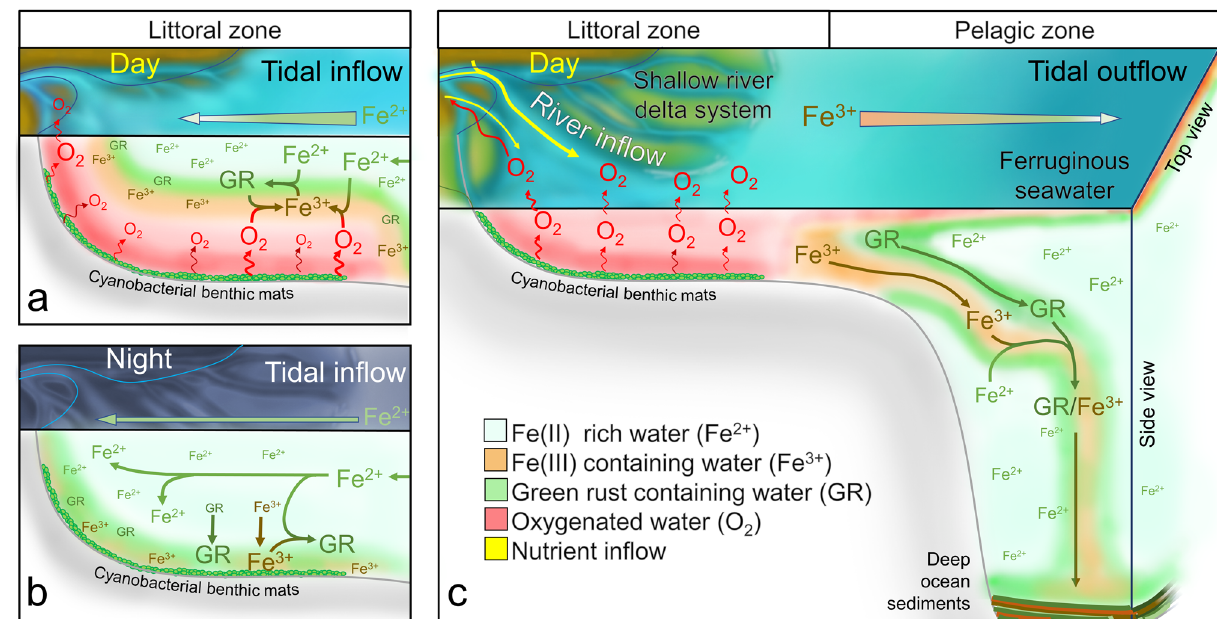
Fig. 1 Graphical model of a proposed Archaean littoral oxygen oasis. a A diurnal tidal in fl ow of ferruginous seawater creates an anoxic Fe(II) layer over oxygenic phototrophic Cyanobacterial mats. Photosynthetic oxygen creates green rust (GR) in the upper boundary layer by partial oxidation of Fe(II) during the day. Closer to the Cyanobacterial mats, Fe(III) is the dominant species, as Fe(II) and precipitating GR is completely oxidised. b During the night time, no oxygen is produced by photosynthesis and the littoral zone becomes ferruginous with precipitated Fe(III) oxides and/or GR, produced in the daytime, at the bottom layer. c Tidal out fl ow transports GR and Fe(III) in the anoxic open ocean, where the remaining Fe(III) can react with Fe(II) to GR. GR and/or Fe(III) sink to the bottom and form deep ocean sediments. High oxygen levels during the day oxidise Fe(II) from the pelagic zone and thereby prevent Fe(II) from reaching the littoral zone. Surplus oxygen not consumed by the oxidation of Fe(II) escapes into the atmosphere leading to localised land weathering, thereby releasing additional nutrients. Additional weathering at the oxygen-rich microbe – mineral interface cannot be excluded. Image created